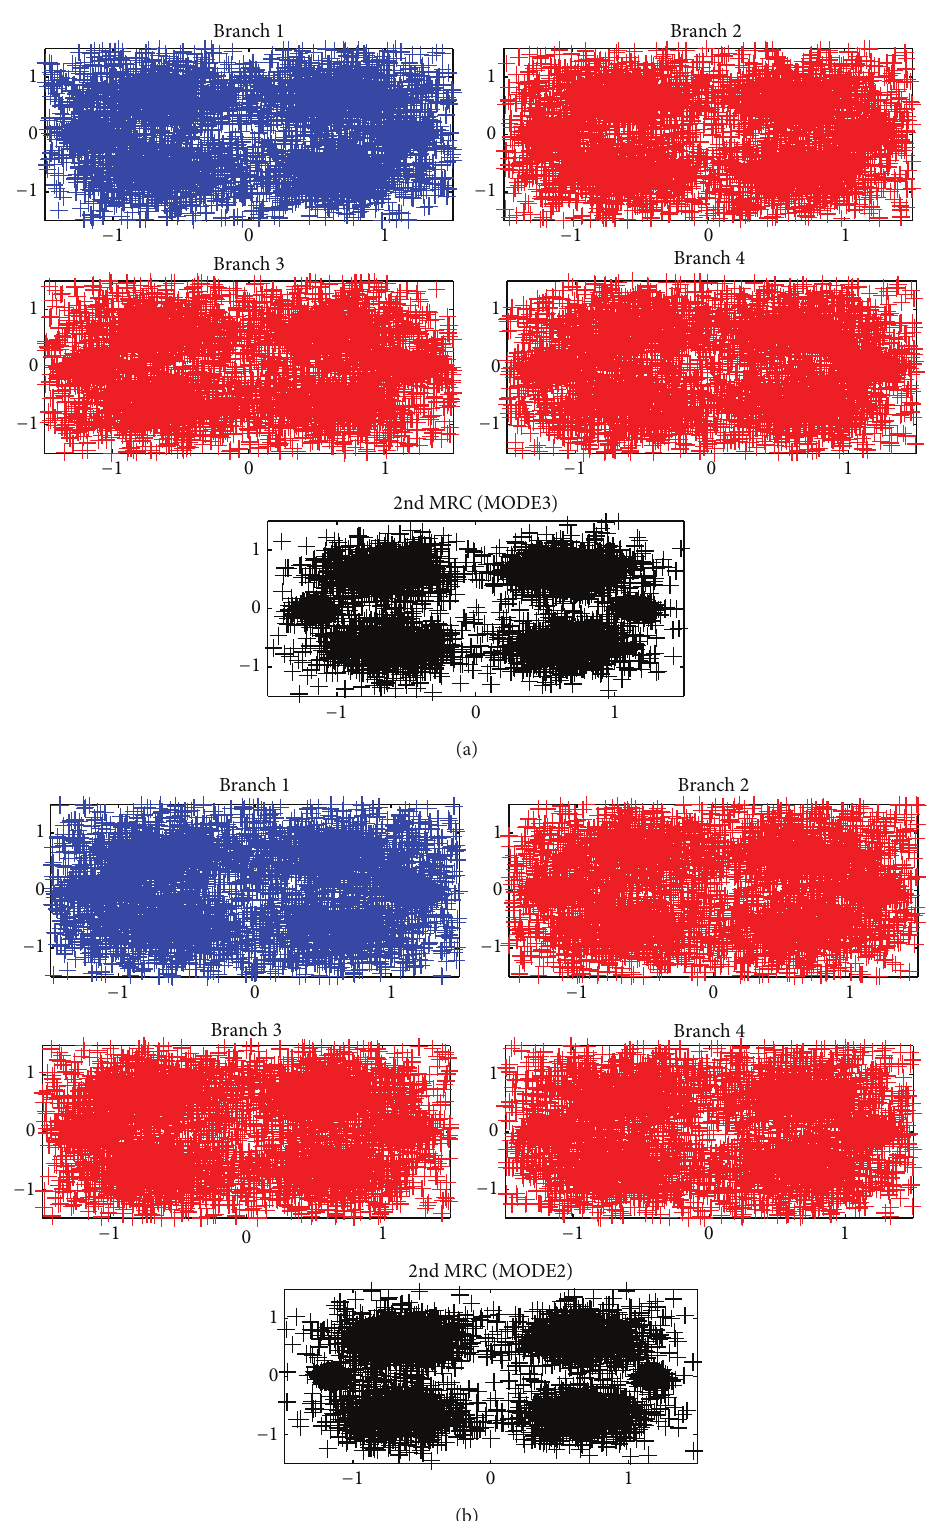
Figure 8: (a) MODE3 QPSK constellations (branches 1 to 4 and MRC, Okinawa). (b) MODE2 QPSK constellations (branches 1 to 4 and MRC,